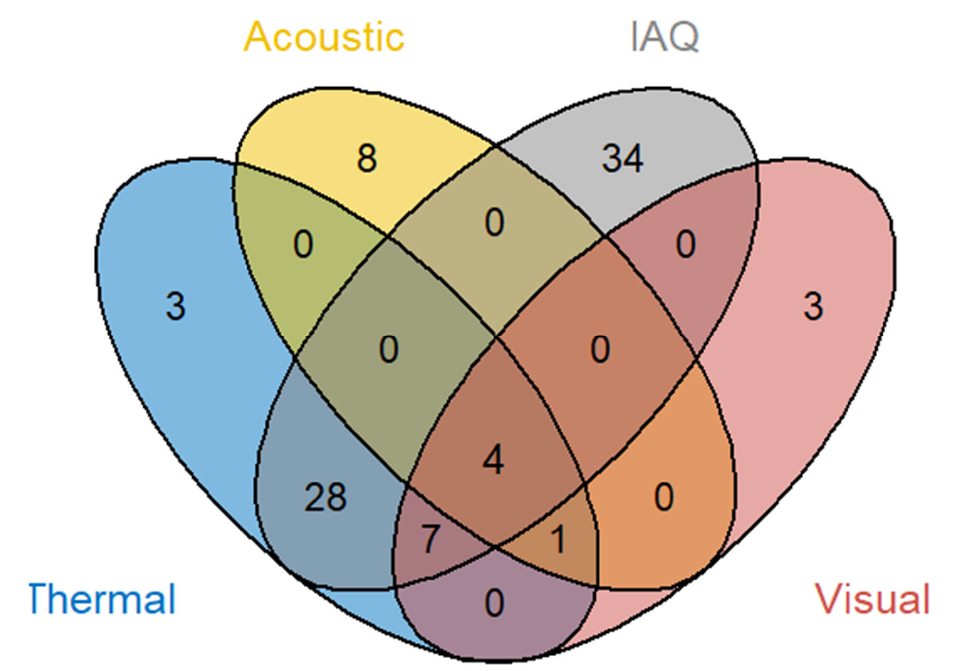
Figure 2. Number of studies according to the IEQ components measured ( n = 88 articles).